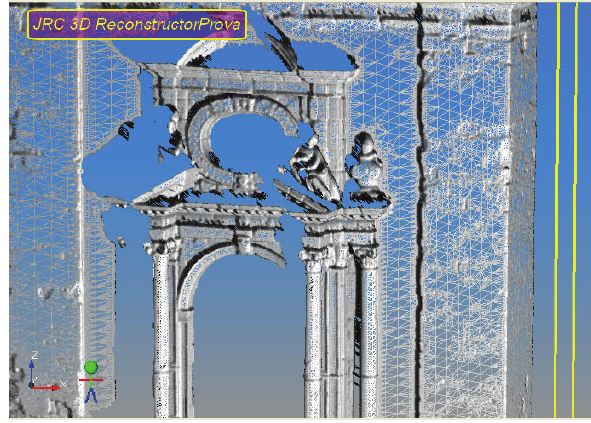
Figure 11. Anime Sante’s church poligonal model